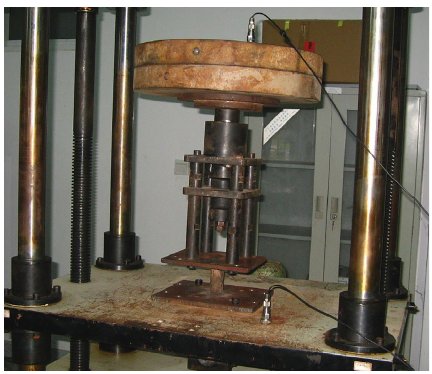
Figure 7: Site map of stiffness and damping test rig for the rubber suspension.